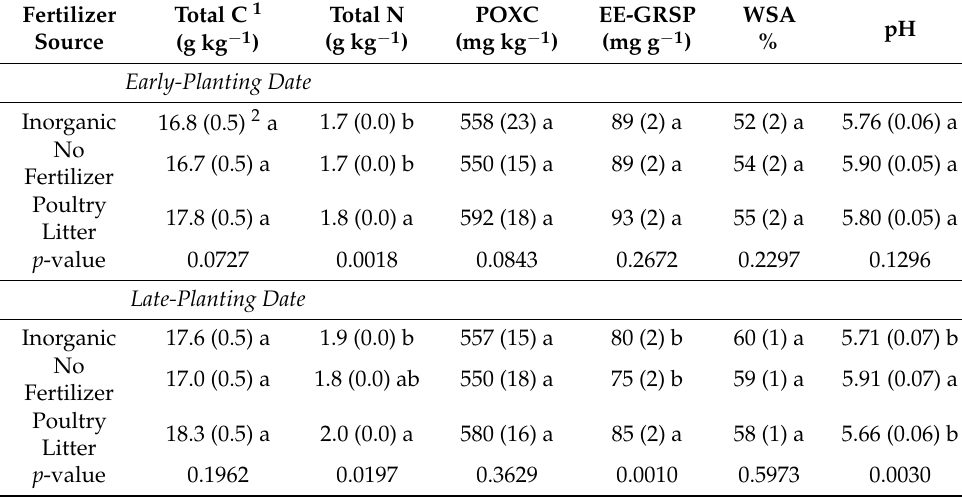
Table 7. Main effects of fertilizer source on soil total carbon (C), total nitrogen (N), permanganate oxidizable carbon (POXC), easily extractable glomalin-related soil protein (EE-GRSP), water stable aggregate (WSA) and soil